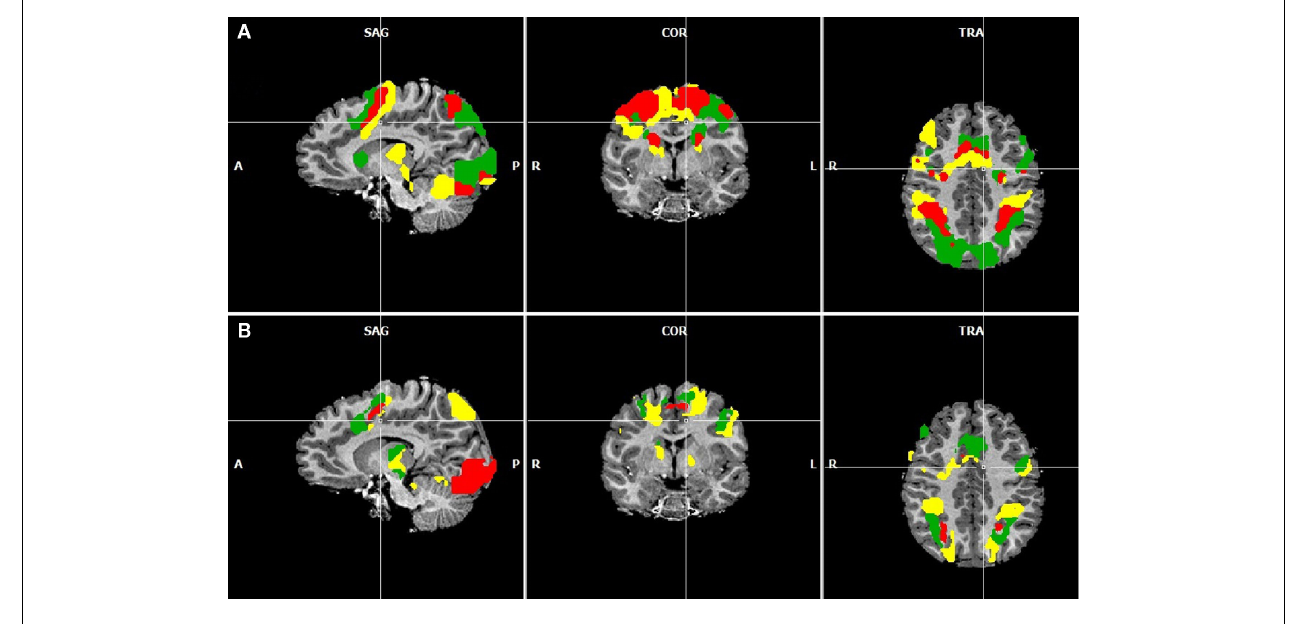
commonly activated during all four numerical tasks (red), regions exclusively activated during symbolic and non-symbolic exact addition (green), and regions exclusively activated during the non-symbolic addition task. All group activations are projected onto a single child brain inTalairach space and are each significant at a cluster-threshold corrected p -value of